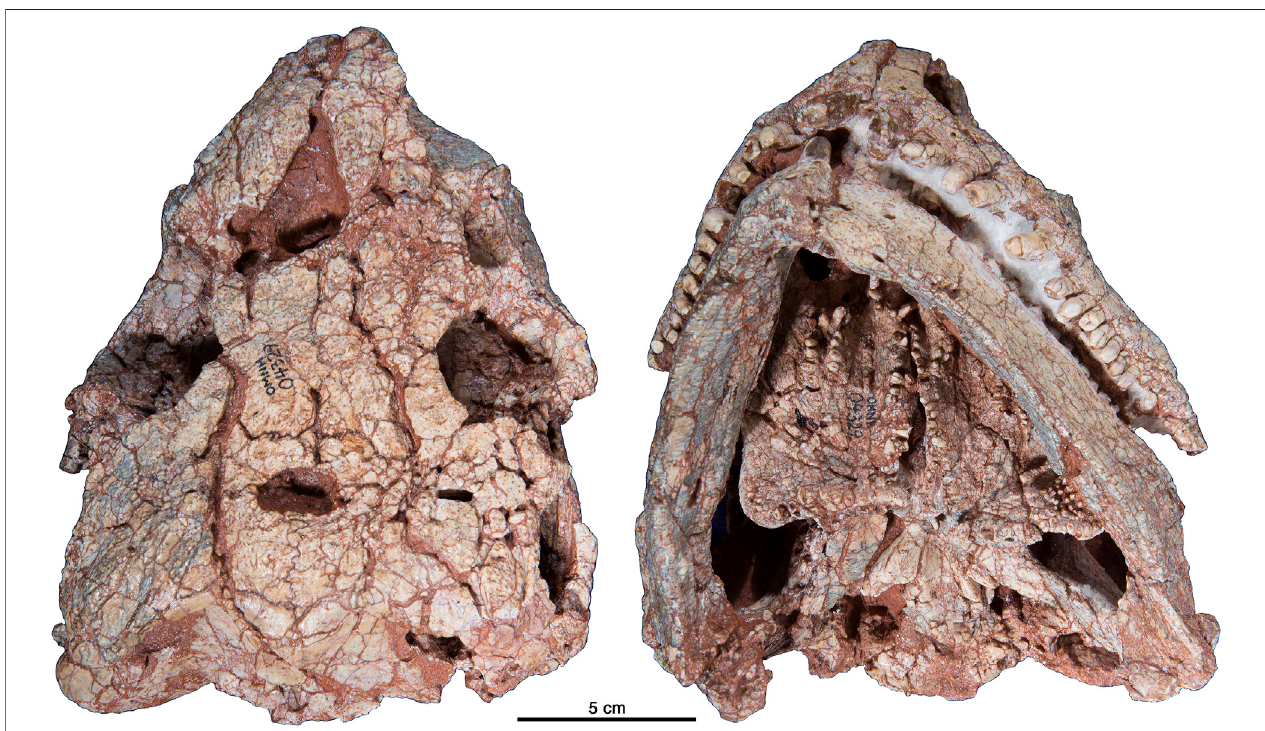
FIGURE 3 | Cotylorhynchus romeri , OMNH 04329, referred specimen. Photographs in dorsal and palatal views.